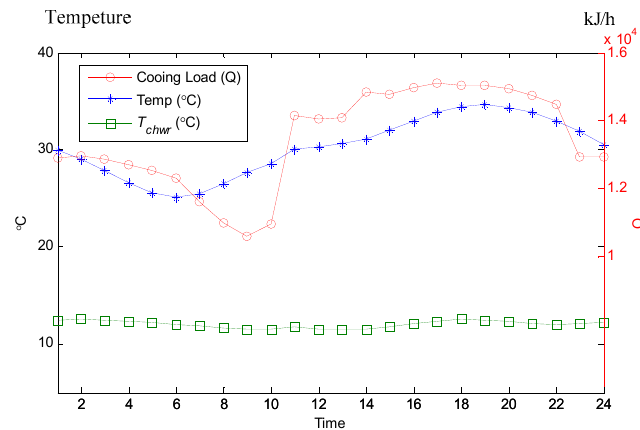
Figure 7. System condition parameters on a summer day.